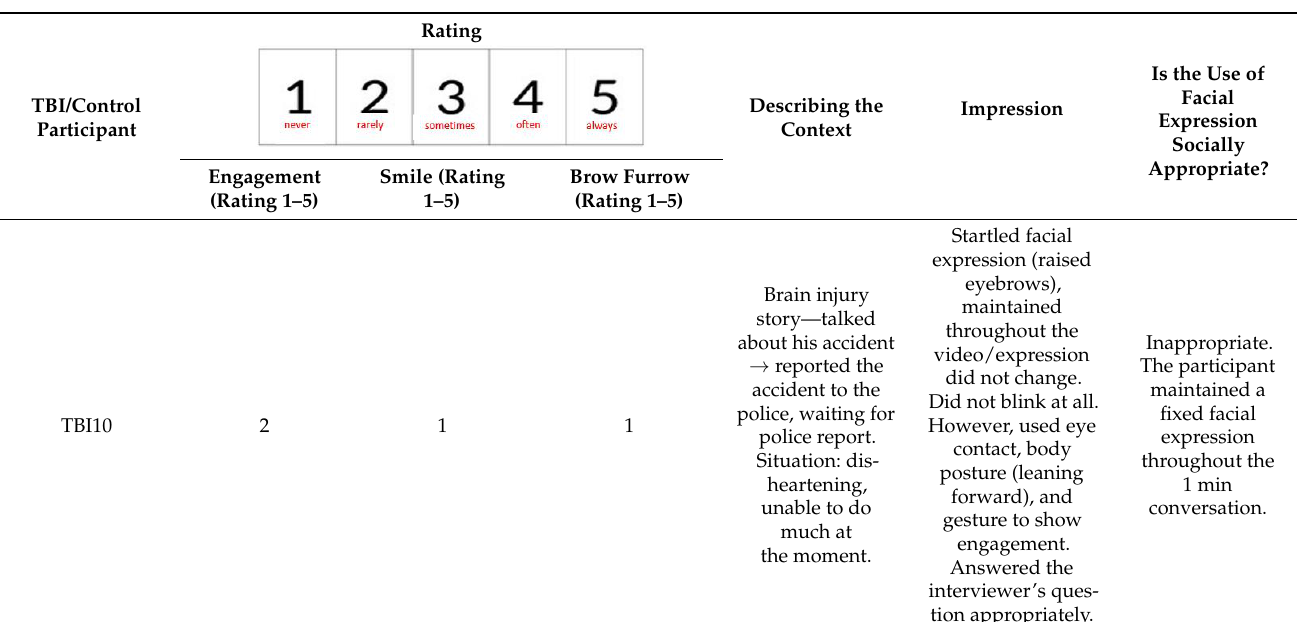
Table 3. Example of qualitative notes using an observation